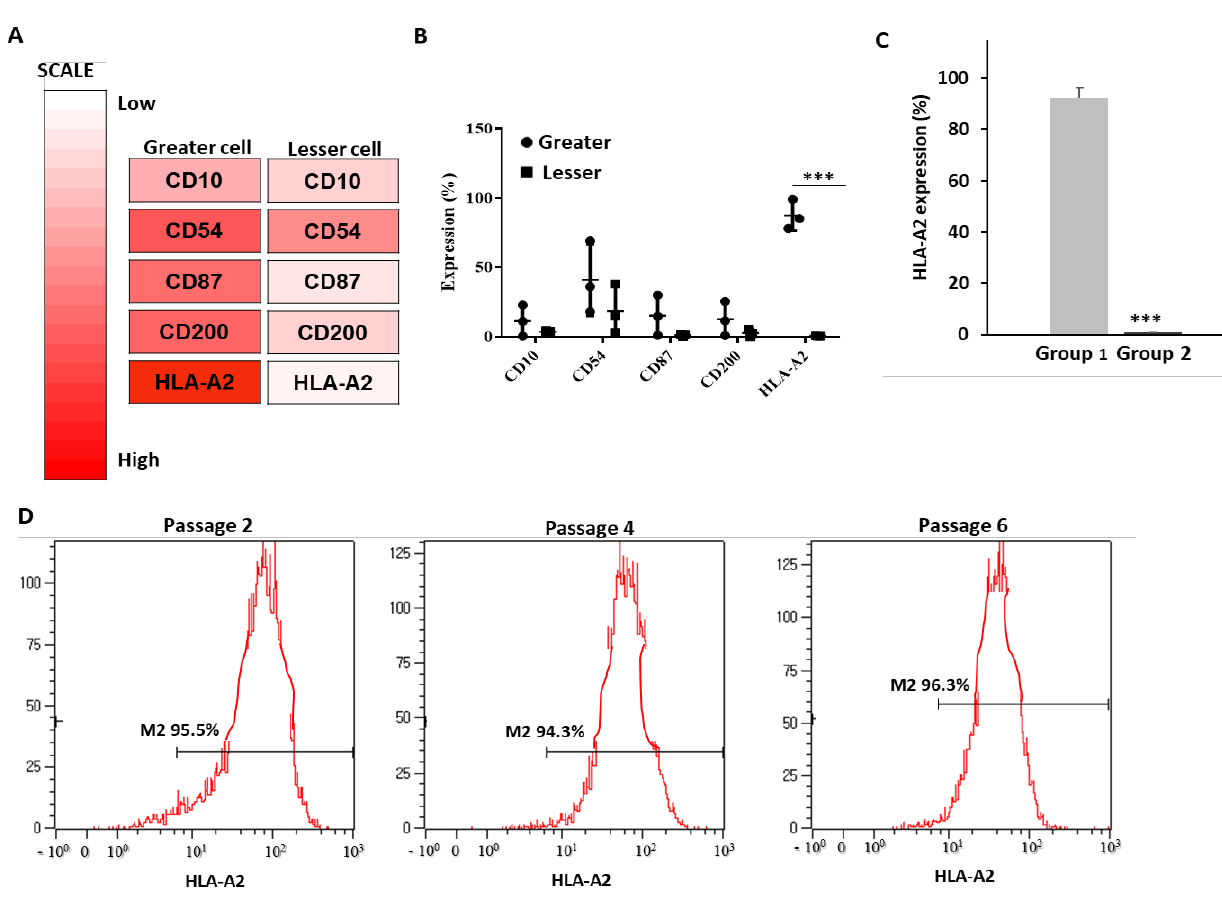
Figure 4. Screening for UCB-MSC cell surface markers. We prepared three lots from each group, labeling those from Group 1 as greater cells and those from Group 2 as lesser cells. ( A ) Heat map analysis showing cell surface markers upregulated in greater compared with lesser cells. ( B ) To con- firm the increase in surface protein expression observed during screening, the CD10, CD54, CD200, and HLA-A2 expression was assessed via flow cytometry (means ± SD, n = 3; *** p < 0.01). HLA-A2 expression was lowest in lesser cells. ( C ) To confirm the downregulation of cell surface proteins shown in panel B, HLA-A2 expression on UCB-MSCs from 15 different donors (Group 1 and Group 2) was analyzed via flow cytometry. HLA-A2 expression was significantly higher in Group 1 com- pared with Group 2. Data are presented as mean ± SD for n = 36 (Group 1) or n = 9 (Group 2) per